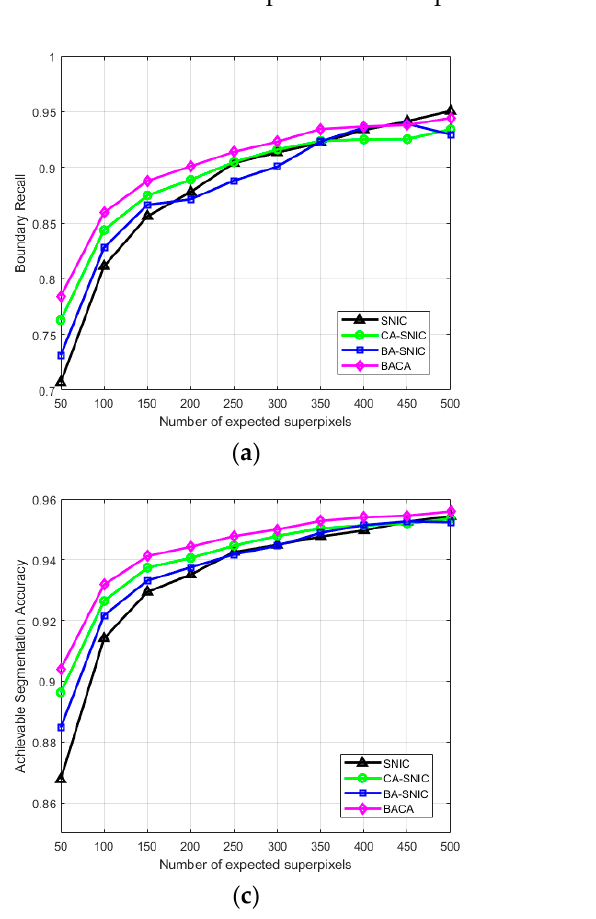
Figure 10. Visual results of superpixels on BSDS500. Each column represents superpixels generated by ( a ) SNIC; ( b ) BA-SNIC; ( c ) CA-SNIC; ( d ) BACA. The excepted number of superpixels is fixed to 100. Alternating columns show each segmented image followed by local details.